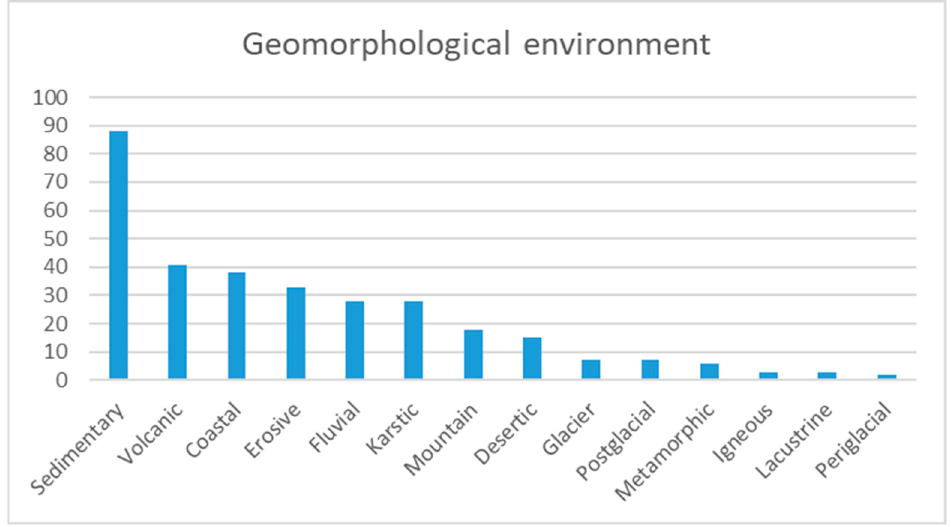
Figure 6. Main study environments of geoheritage, geoconservation and geotourism around the world. the